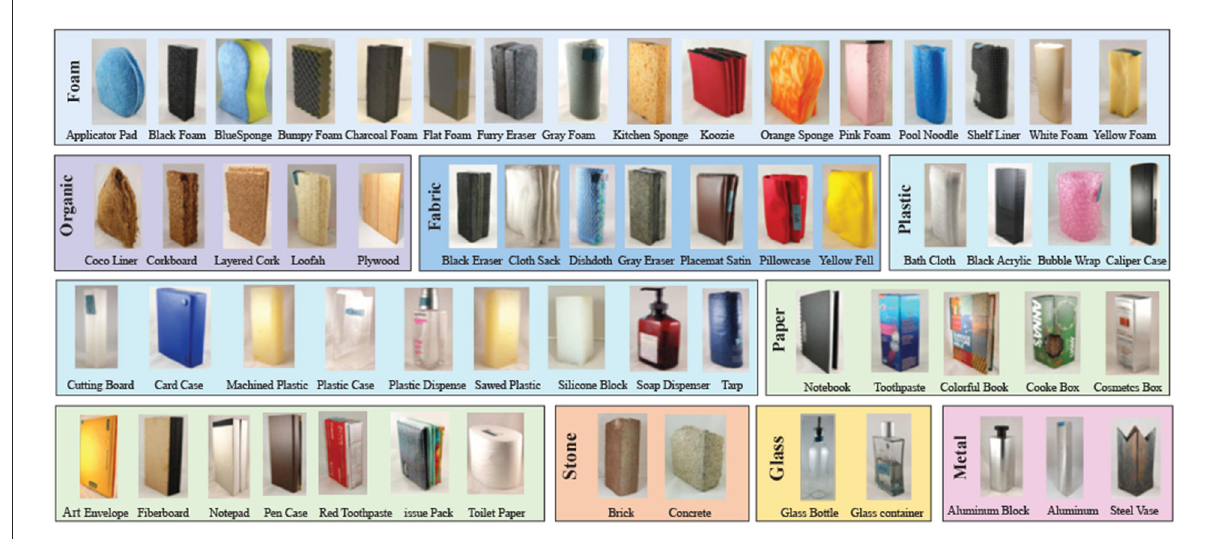
FIGURE4 The PHAC-2 contains 60 objects, which are organized by their primary material. The original images are from Chu et al. (2015). It has been reproduced with permission from Elsevier, available at